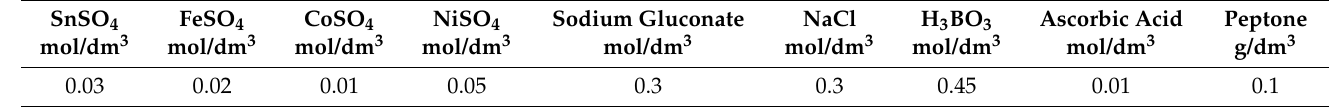
Table 1. Composition of the electrolyte and concentrations of the constituting compounds.